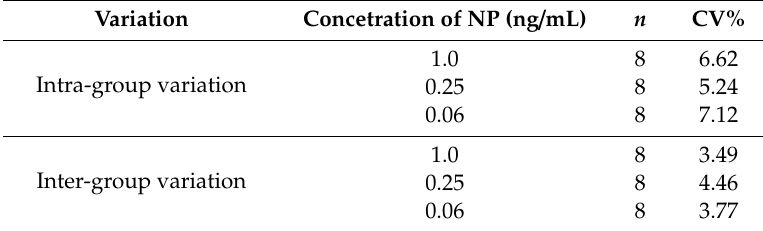
Figure 6. Absorbance changes of the system for the detection of NP after the probe is placed at 4 °C ( A ) and 37 °C ( B ) for different days; ( C ) Absorption spectrum of AuNPs probes stored at 37 °C for seven days and 4 °C for four months. ( D ) Appearance of the AuNPs versus AuNPs probe. The dashed lines indicate the cut-off values (mean + 3 × SD) for each experiment. Table 3. Measurement of intra- and intergroup variations of the AuNP-based ELISA.